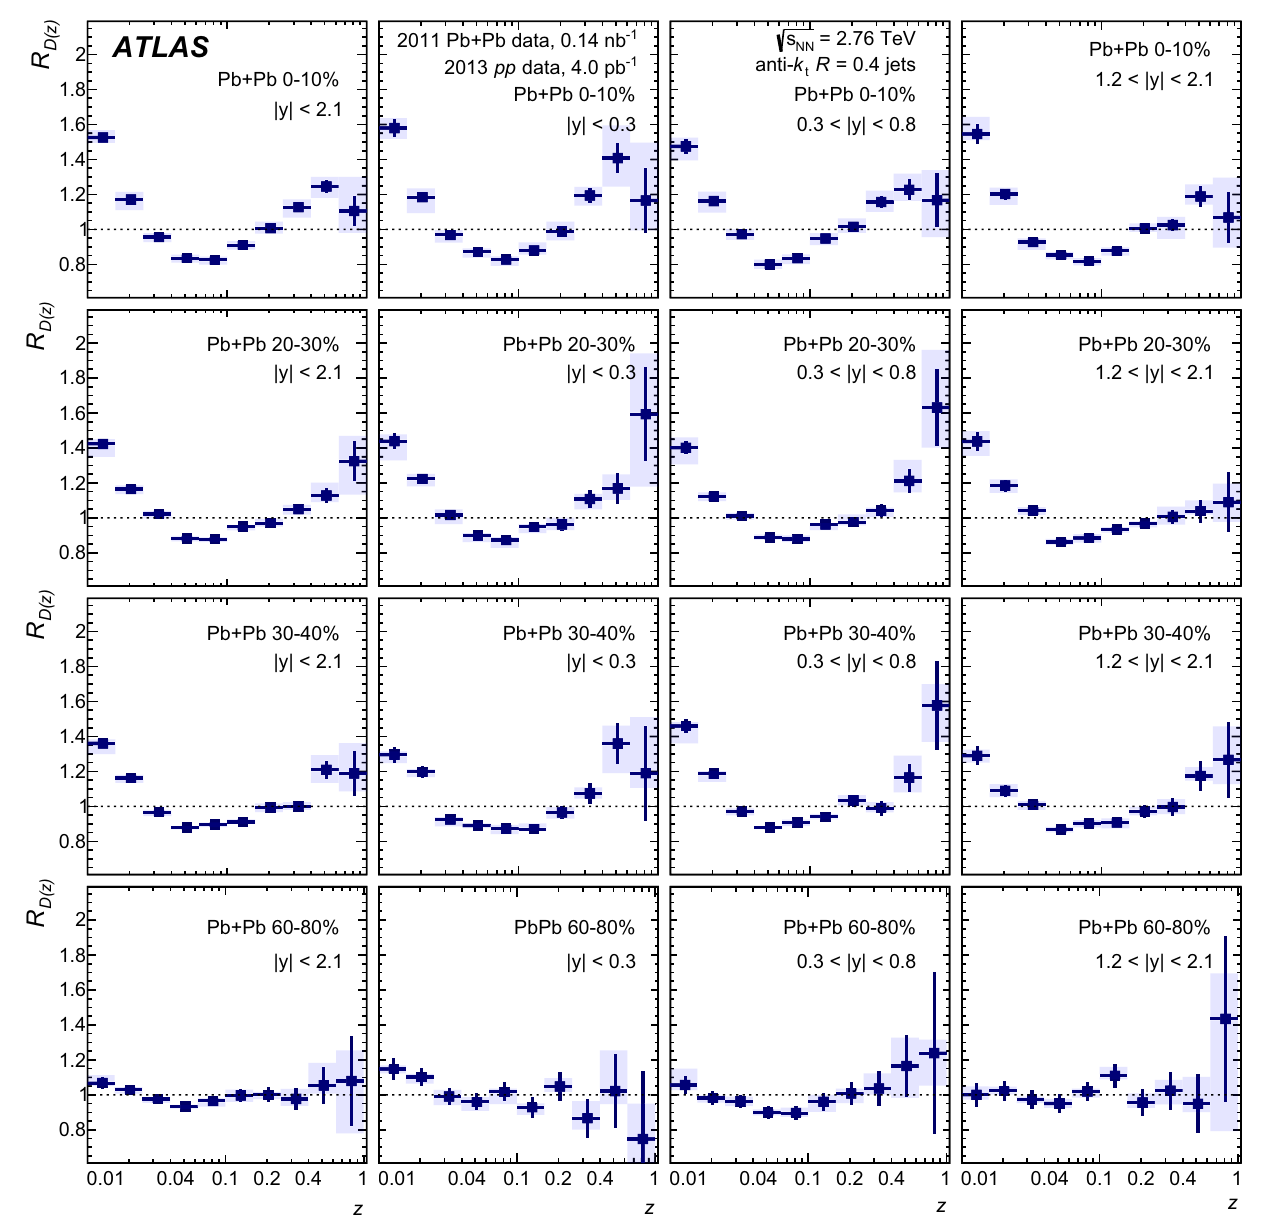
Fig. 5 The ratio R D ( z ) of unfolded D ( z ) distributions measured in heavy-ion collisions to unfolded D ( z ) distributions measured in pp col- lisions. The R D ( z ) distributions were evaluated in four different cen- trality bins ( rows ) and four different selections in jet rapidity of jets